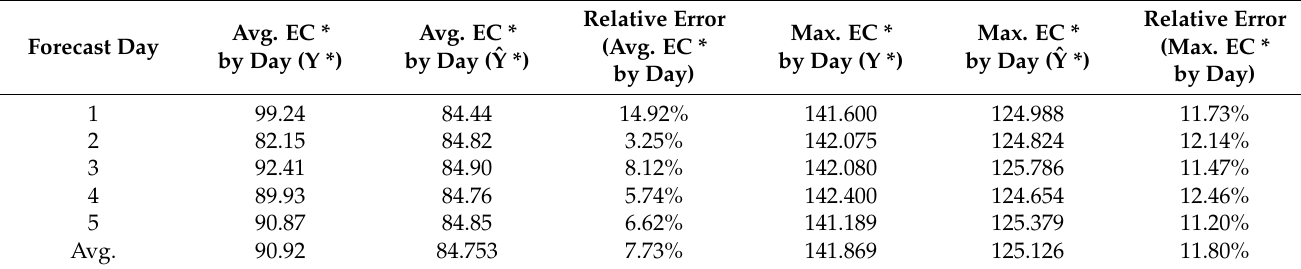
Table 8. Calculation of the relative error of the daily energy consumption (average and maximum) with respect to the testing-set (model: C1-T50).